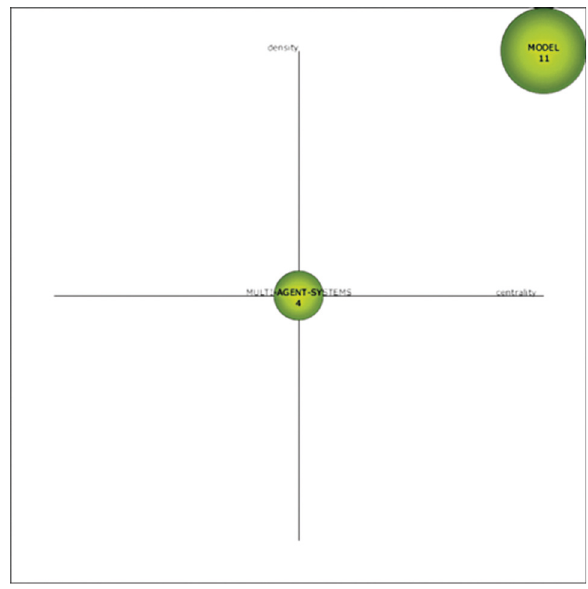
Figure 16: 2001–2005 strategic coordinate